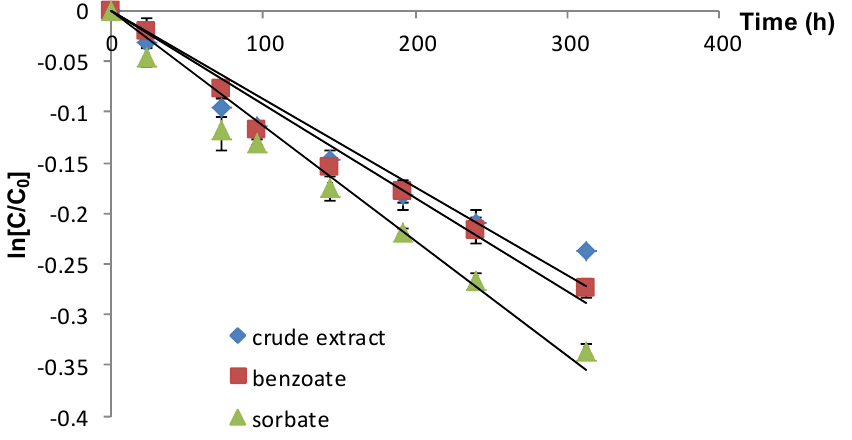
Figure 2. Influence of different food preservatives on the anthocyanin stability during storage at 22 °C (vertical lines represent SD, n = 4).